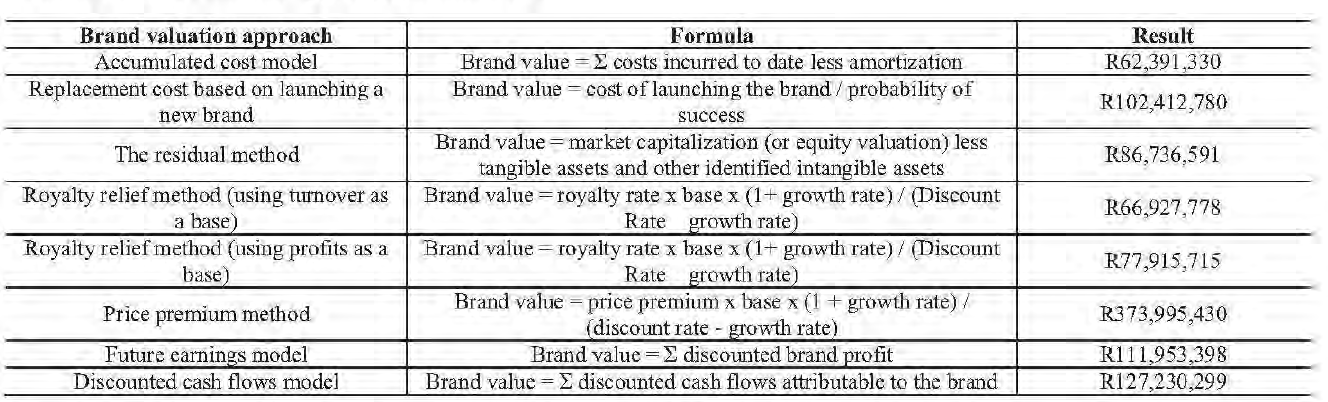
Table 1: Brand valuation approach calculation results Brand valuation